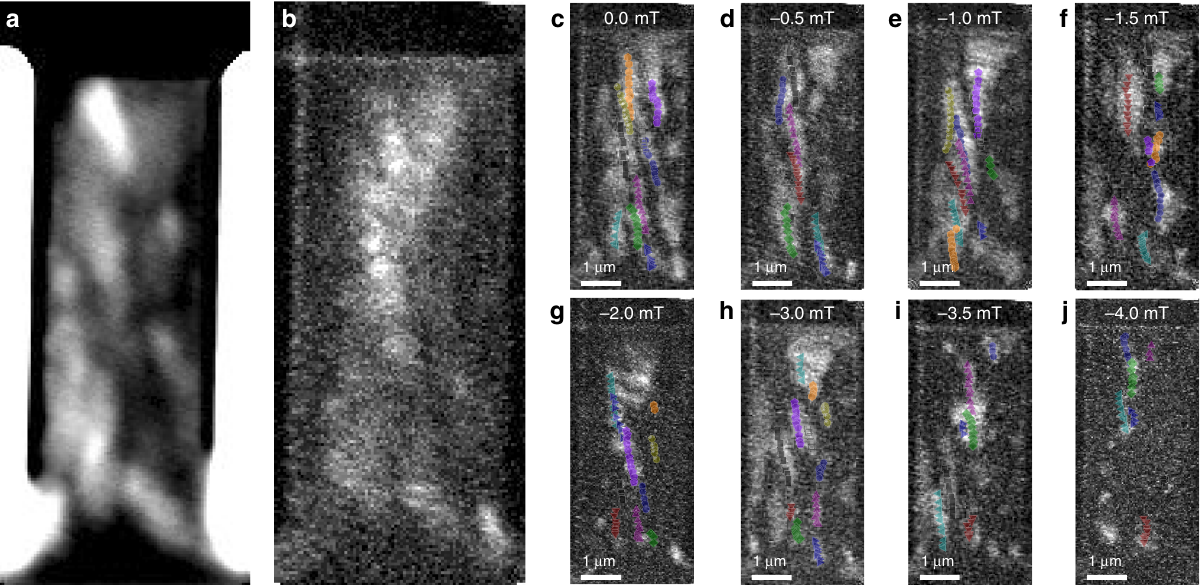
Fig. 6 Skyrmion motion maps. a Average intensity map of all STXM images. Bright regions represent areas with high probability of containing a reversed magnetic domain or skyrmion. b Average intensity map of the absolute difference between consecutive images. Bright regions show high probability of an expanding magnetic domain or a moving skyrmion. c – j Average intensity map of the absolute difference between consecutive images obtained at each applied fi eld, superimposed are the skyrmion centre positions (coloured symbols) throughout the pulse series from Fig. movable. Figure 6b is an average intensity map of the differences Not all nucleated skyrmions were observed to move. Out of 197 between two consecutive images. Bright areas indicate regions nucleated skyrmions only 85 (44%) were seen to move in where a magnetic change has occurred due to the current pulse, response to current pulses. Figure 7a shows skyrmion nucleation either skyrmion growth or motion. Figure 6c – j show the sky- spots as open dark blue circles. The overlaid solid light blue rmion centre positions throughout the excitation sequence at circles highlight those skyrmions which then moved. each applied fi eld superimposed onto the average intensity images Figure 7b – d shows examples of phenomena that were observed obtained at each applied fi eld. A change in the skyrmion centre to affect the skyrmion trajectories. We identify two primary represents a motion event and thus by combining the average reasons for changes in the skyrmion trajectory: De fl ection from intensity map with the skyrmion centre motion one can distin- pinning sites and de fl ection from neighbouring magnetic guish growth from motion events. domains or skyrmions. Skyrmions (1), (3) and (4) in Fig. 7b – d